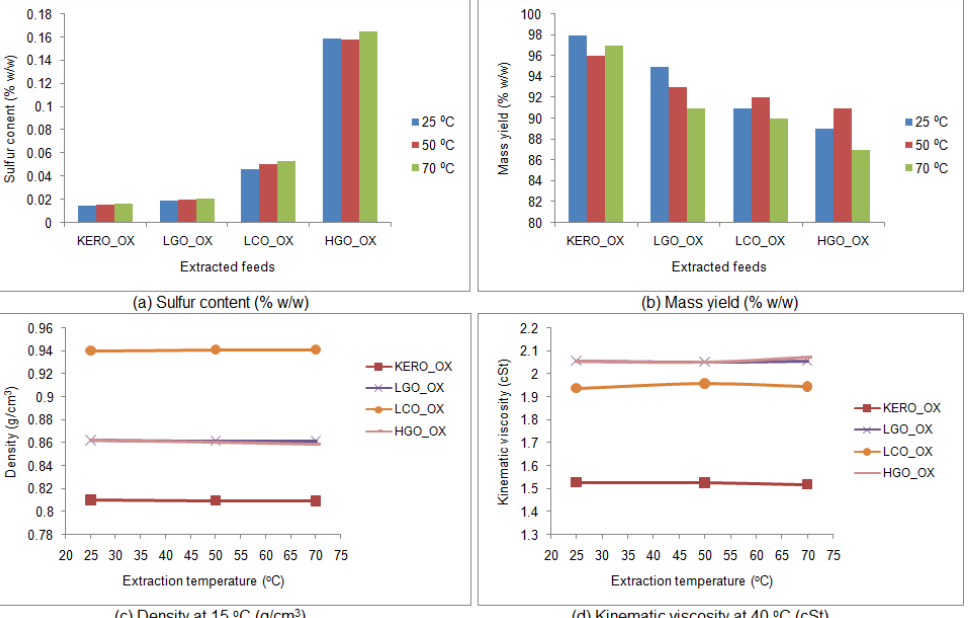
Figure 11. Influence of temperature on the desulfurization capability of the fresh [BMIM][HSO 4 ]: ( a ) sulfur content of the surrogate raffinates (% w / w ), ( b ) mass yield of the surrogate raffinates (% w / w ), ( c ) density of the surrogate raffinates at 15 °C (g/cm 3 ), ( d ) kinematic viscosity of the surrogate raffinates at 40 °C (cSt). (KERO_ OX: oxidized surrogate kerosene, LGO_OX: oxidized surrogate LGO, LCO_OX: oxidized surrogate LCO, HGO_OX: oxidized surrogate HGO).